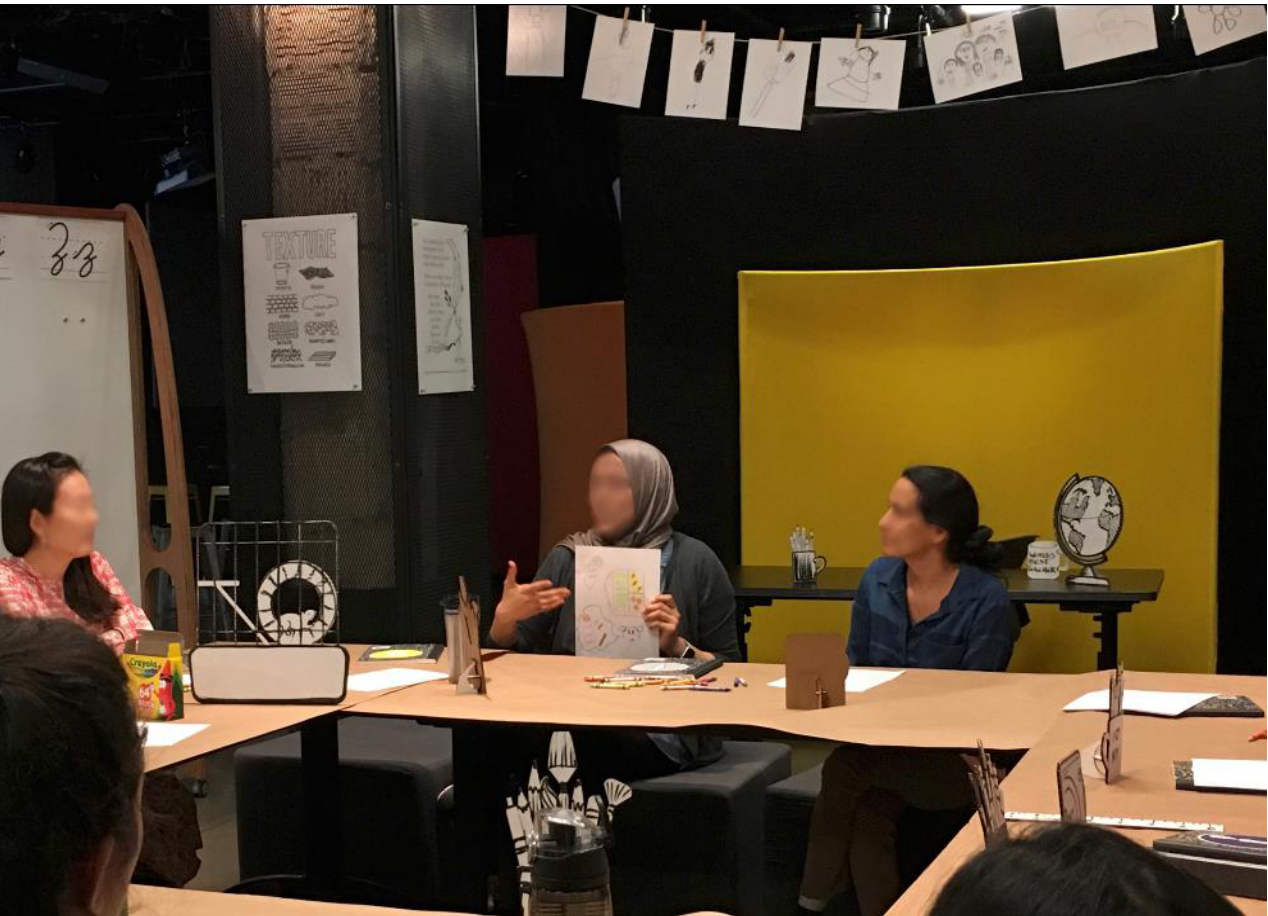
Figure 1. Image from section one of a practice workshop to display the research space and activity. The individuals in the photographs are not the research